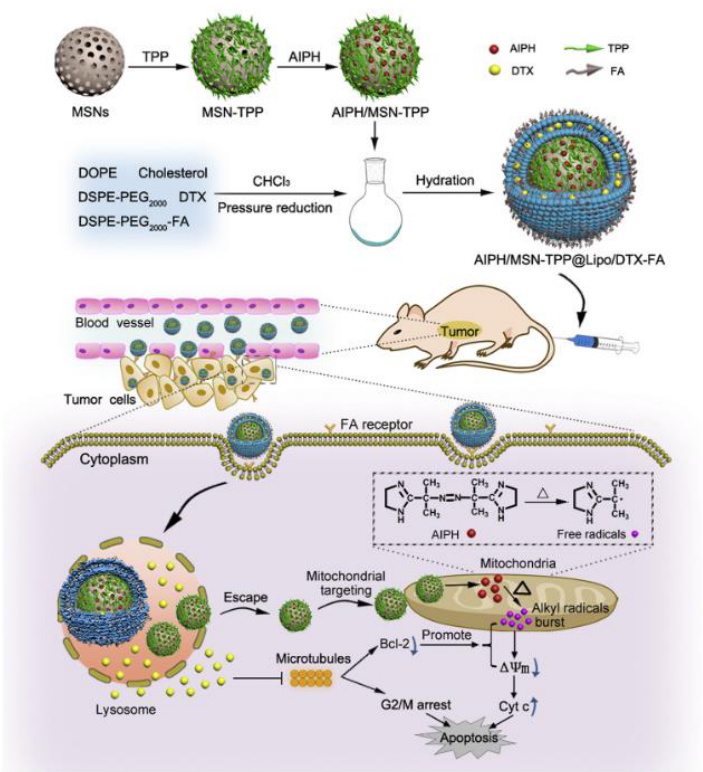
Figure 18. Schematic representation of preparation of MSN particle in lipid shell and mechanism of its antitumor activity (MSN = mesoporous silica nanoparticle; TPP = triphenylphosphine; AIPH = 2,2 (cid:48) - azobis[2-(2-imidazolin-2-yl)propane] dihydrochloride; DTX = drug docetaxel; FA = folic acid; DOPE = dioleoylphosphoethanolamine; DSPE-PEG 2000 = 1,2-distearoyl-sn-glycero-3-phosphoethanolamine- N-[amino(polyethylene glycol)-2000] (ammonium salt). Reprinted with permission from